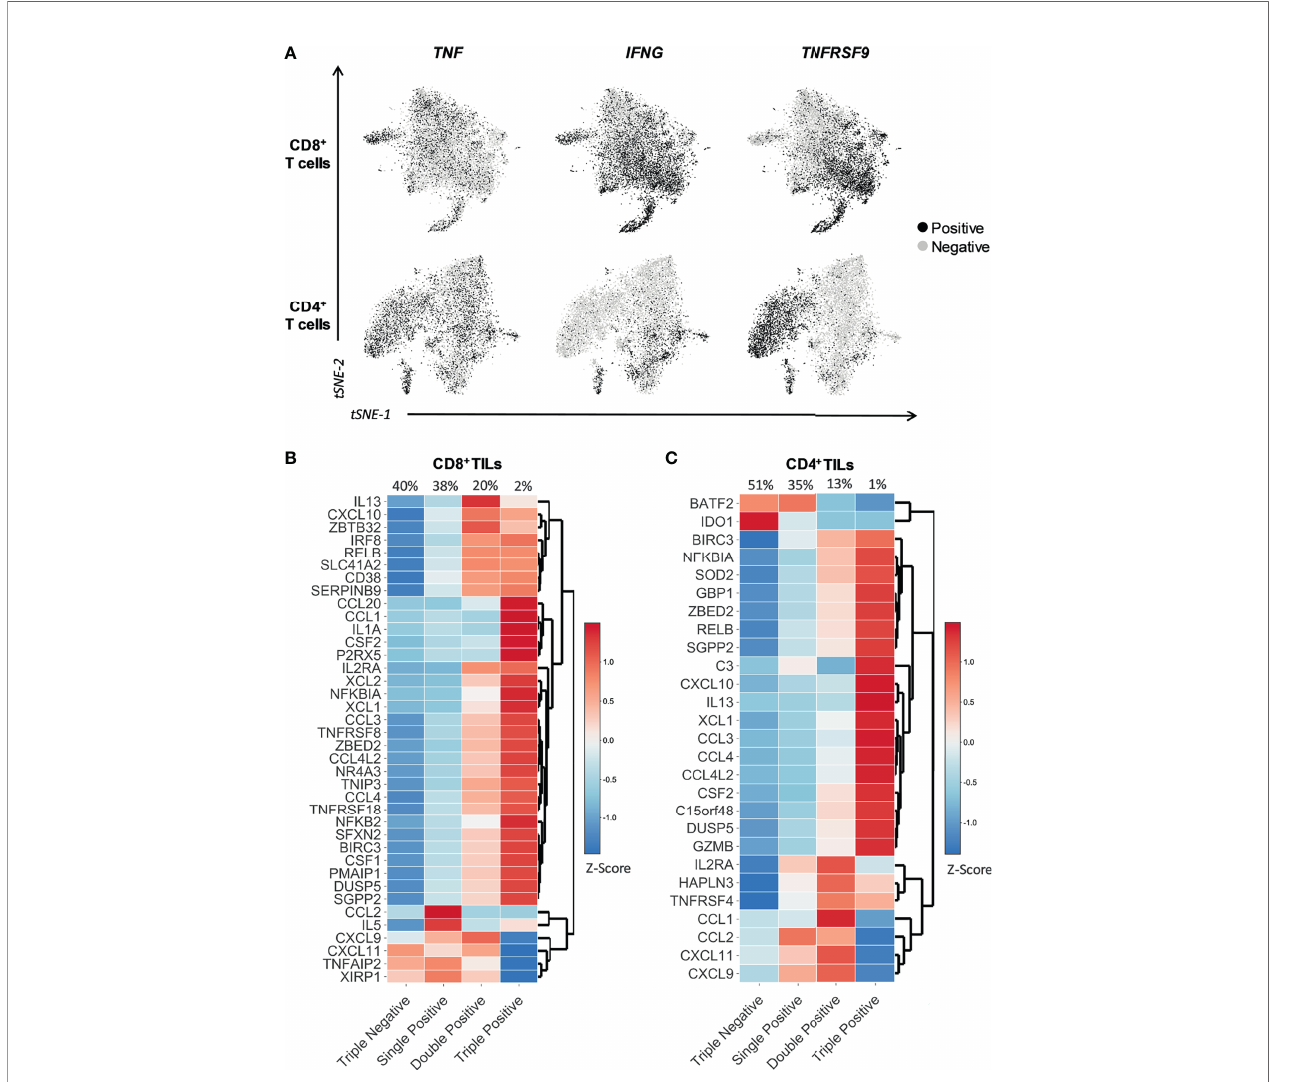
FIGURE 3 | TNFRSF9, TNF , and IFNG allow the identi fi cation of tumor-speci fi c reactive TILs in situ. t-SNE plots and heatmaps showing data from 12748 single CD8 + TILs and 10654 single CD4 + TILs isolated from tumor tissue of four different cancer types (non-small-cell lung cancer, hepatocellular carcinoma, colorectal cancer, and melanoma). Six selected scRNAseq datasets from public repositories were re-analyzed to produce this fi gure (see Supplementary Table 2 ). (A) Expression of the gene indicated above each plot, represented as black for positive expression and grey for negative. TNFRSF9, TNF , and IFNG were differentially expressed within both CD8 + and CD4 + TIL subsets. (B, C) The heatmaps show the expression (Z-score) of the genes belonging to the (B) CD8 and (C) CD4 tumor-speci fi c activation gene sets within four functional clusters of CD8 + and CD4 + TILs identi fi ed in situ through the differential expression of TNFRSF9, TNF , and IFNG . The four functional clusters are characterized by the expression of either zero (Triple Negative), one (Single Positive), two (Double Positive), or three (Triple Positive) of the three genes of interest ( TNFRSF9, TNF , and IFNG ). TNFRSF9, TNF , and IFNG represent an ef fi cient and effective surrogate combination for a much broader panel of functions associated to tumor reactivity, and can potentially identify the majority of the tumor-speci fi c reactive TIL repertoire in situ